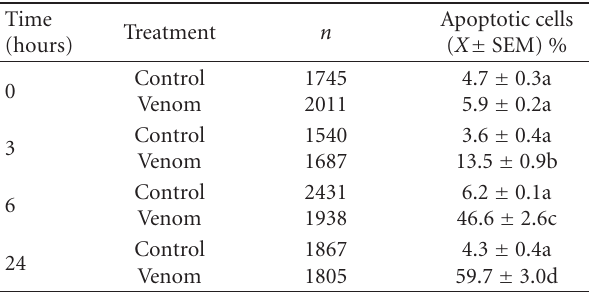
Table 2: Incidence of apoptosis in brain tissue of S. bullata enveno- mated by N. vitripennis